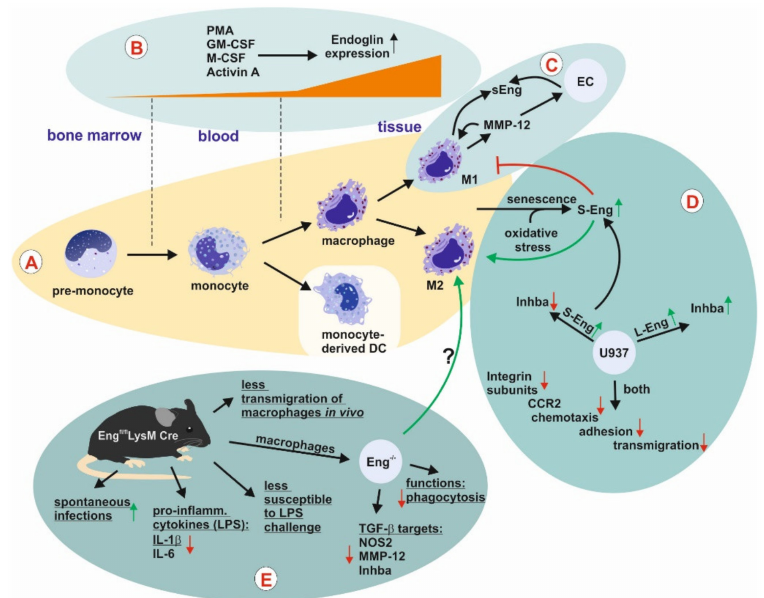
Figure 5. Endoglin expression and function in macrophages. ( A ) Bone marrow-derived pro-monocytes di ff erentiate to monocytes which enter the circulation. ( A , B ) Monocytes extravasate, enter tissues, di ff erentiate to macrophages, and are polarized to anti- (M2) or pro-(M1) inflammatory macrophages upon the appropriate stimuli, of which both express Endoglin (Eng). In the course of these processes L-Eng is upregulated. Monocyte-derived dendritic cells have not been analyzed for Eng expression so far. Cellular aging and oxidative stress causes senescence accompanied by proportional higher upregulation of S-Eng. ( C ) M1 polarized (pro-inflammatory) macrophages are pro-inflammatory and anti-angiogenic. This is in part due to the secretion of MMP-12 which is missing in the secretome of M2 macrophages. Secretion of MMP-12 causes shedding of Eng in the membranes of macrophages and EC leading to the liberation of sEng, which is an anti-angiogenic molecule. ( D ) For functional analysis, U937 L- and S-Eng transfectants were analyzed by proteome [135] and transcriptome [133] analysis. In line, both studies showed a reduced expression of di ff erent integrin subunits in both transfectants accompanied by reduced adhesion. However, the data of Aristorena and colleagues [135] suggested that S-Eng blocks M1 and favors M2 polarization, whereas the L-Eng data were not that clear. Both studies showed in accordance that L-Eng up- and S-Eng down-regulates the inhibinB α (activin A) subunit. ( E ) A myeloid lineage-specific Eng knockout showed spontaneous infections and a lower inflammatory response in vivo coupled to compromised inflammatory macrophage functions in vitro , implying less M1 activity in the absence of Eng. Abbreviations used: CCR2, C-C chemokine receptor type 2; DC, dendritic cell; EC, endothelial cell; Eng, Endoglin; GM-CSF, granulocyte-macrophage colony-stimulating factor; IL, interleukin; LPS, lipopolysaccharide; M-CSF, macrophage colony-stimulating factor; MMP, matrix metalloproteinase; NOS2, inducible NO-synthase; PMA,